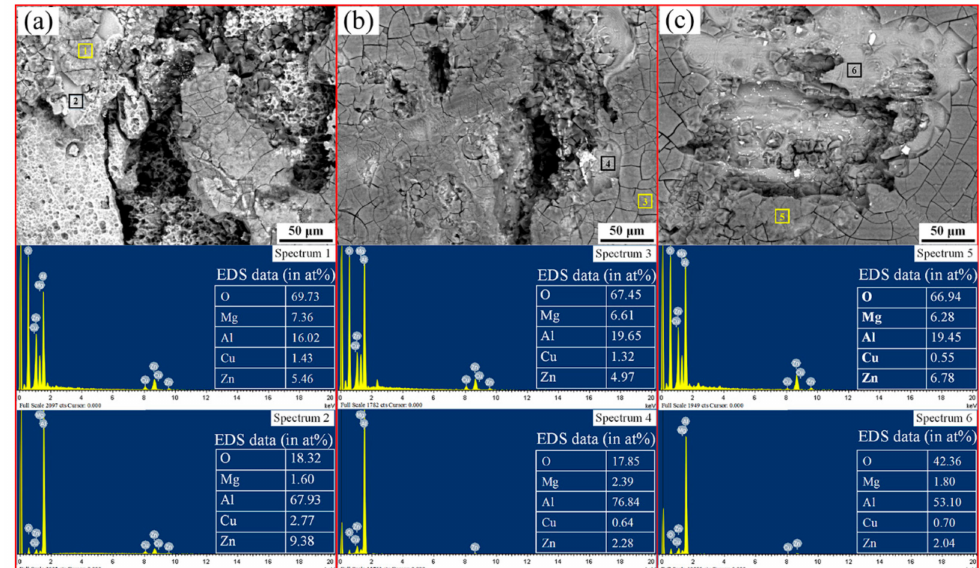
Figure 5. SEM / EDS analysis of the surface corrosion products and oxide layer of the samples after the immersion test: ( a ) BM, ( b ) UR1, and ( c ) UR12-P.